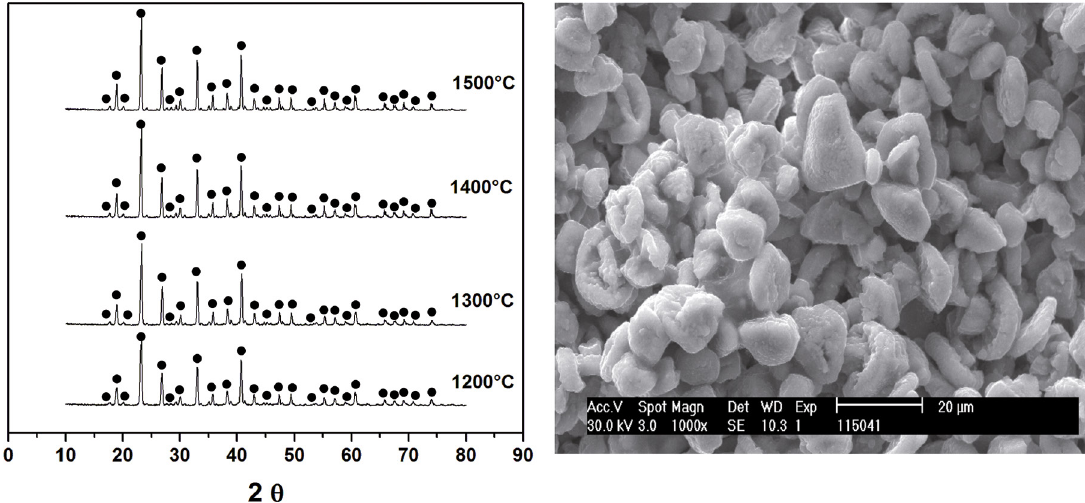
Figure 5. On the left patterns of X-ray diffraction of samples head treated at different temperatures with an isotherm of 4 hours. •: Sr